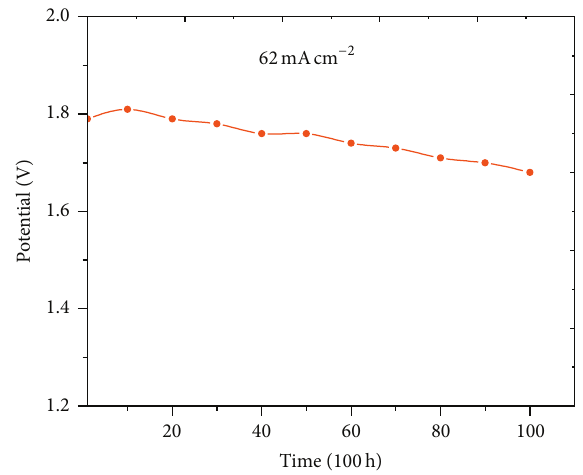
Figure 10: Performance stability of the MLSPBFC operating at current density of 62mAcm −2 at room temperature. [Fuel]: 2 M formic acid + 0.5 M NaOH. [Oxidant]: 0.1 M perborate + 0.5 M H 2 SO 4 . Stream flow rates: 0.3 mLmin −1